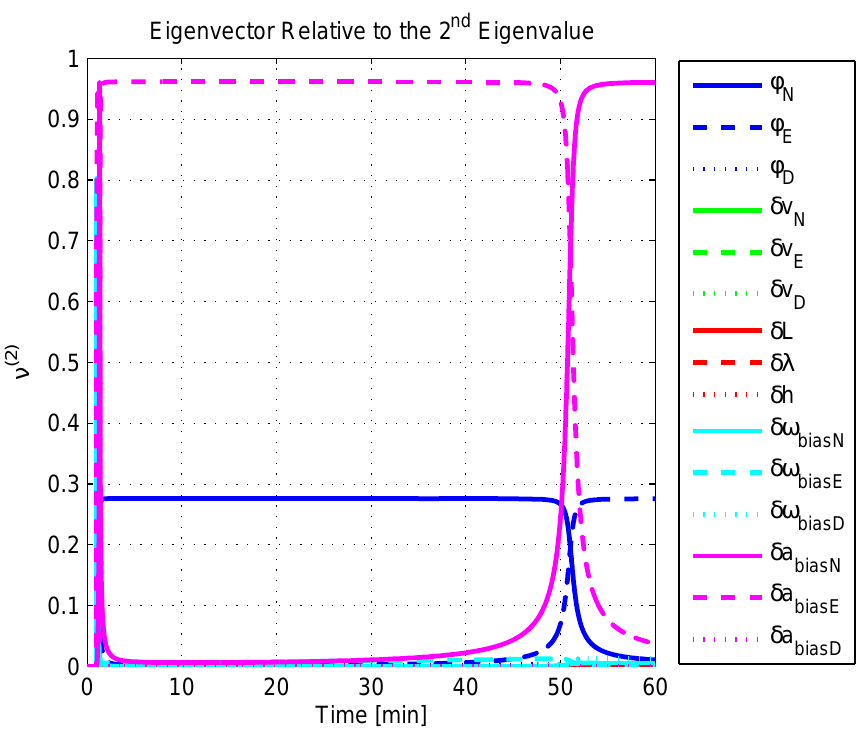
Figure 9. Eigenvector relative to the second eigenvalue in the simulated